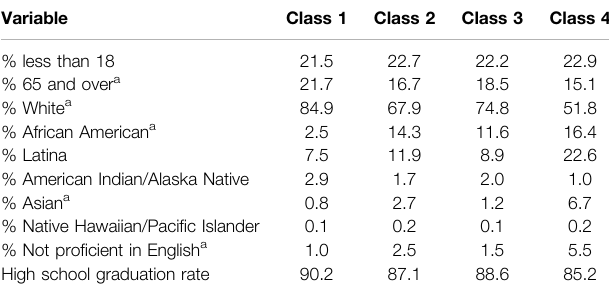
TABLE 5 | Means for demographic variables by latent class.